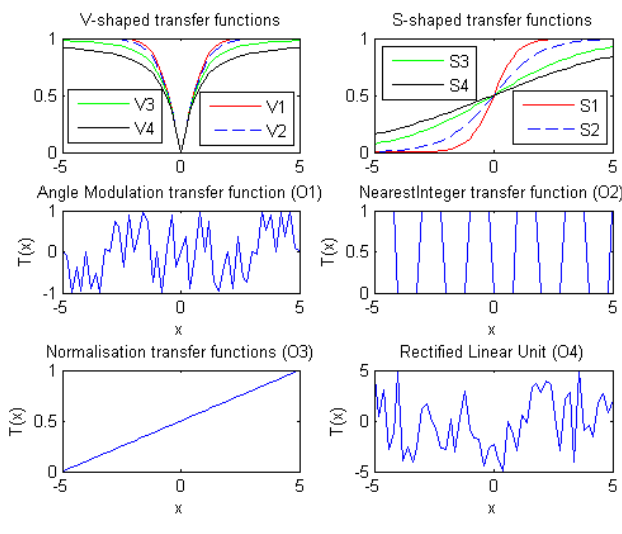
Figure 1. Twelve transfer functions.